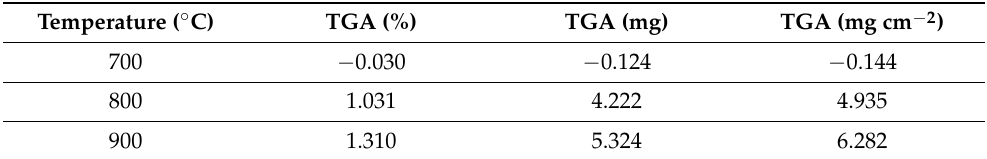
Figure 2. TGA results for all the samples investigated at different oxidation temperatures. Table 2. Final weight changes in %, mg, and mg cm − 2 (weight change per specific surface area of the samples).